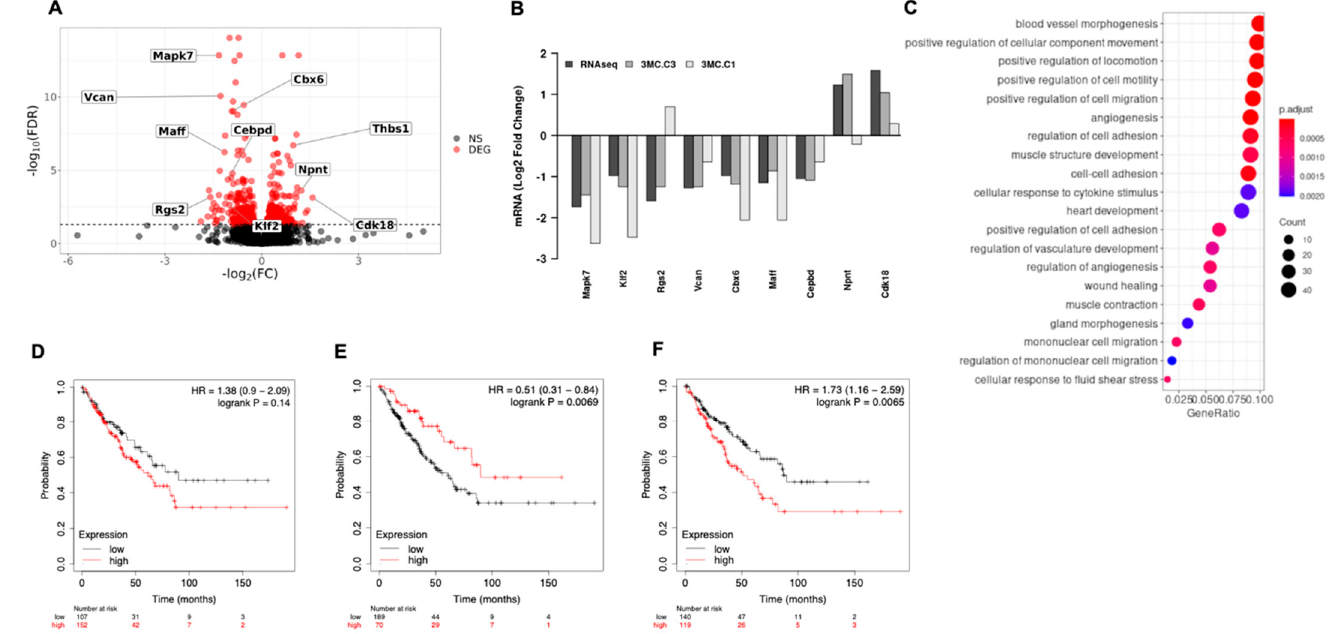
Figure 5. ERK5 mediates transcriptional landscape in 3MC-derived cell lines. ( A ) Volcano plot showing the effect size of ERK5 attenuation on gene expression (log2 fold change in ERK5-depleted over control cells) versus statistical significance of the difference in expression between conditions ( − log10 of the FDR-adjusted p -values). Each dot represents an independent gene, and DEG (FDR < 0.05) is shown in red color. Text labels show the identity and location of the genes selected for vali- dation. ( B ) Effect of ERK5 attenuation on the expression of the genes selected for validation. The figure shows the effect size (log2 fold change in ERK5-depleted over control cells) as determined from the RNAseq (RNAseq) data and from RT-qPCR determinations in cell pools derived from two independent infections (3MC-C3 and 3MC-C1). ( C ) Top 20 Gene Ontology terms significantly asso- ciated with genes differentially expressed upon ERK5 suppression. The graph represents the frac- tion of DEG with the indicated GO term. The color of the symbols indicates the statistical signifi- cance of the association (adjusted p -value) and their size, the absolute number of DEG genes with the indicated GO label. ( D ) Kaplan–Meyer comparing prognosis in terms of Overall Survival (OS) for two groups of patients, those with high (in red) and low (in black) expression levels of ERK5 for sarcoma patients from TCGA dataset. Hazard ratio (HR) and p -value (log rank P) showed in the upper right corner of the panel. ( E ) Kaplan–Meyer comparing prognosis in terms of OS for two groups of patients, those with high (in red) and low (in black) expression levels of the upregulated genes associated with ERK5 abrogation for sarcoma patients from TCGA dataset. HR and p -value (log rank P) showed in the upper right corner of the panel. ( F ) Kaplan–Meyer comparing prognosis in terms of OS for two groups of patients, those with high (in red) and low (in black) expression levels of the downregulated genes associated with ERK5 abrogation for sarcoma patients from TCGA dataset. HR and p -value (log rank P) showed in the upper right corner of the panel.